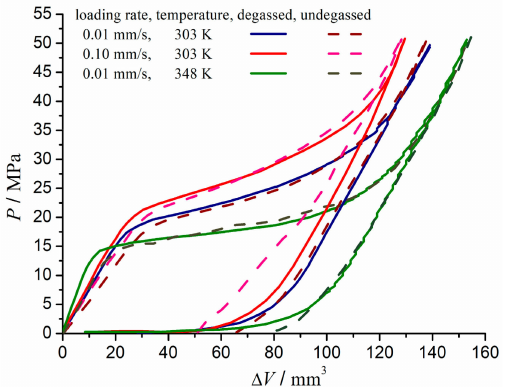
Figure 5. Comparision of the first loading/unloading cycle of undegassed and degassed glycerol/zeolite system (loading rate 0.01 mm/s and 0.10 mm/s; system temperature 303